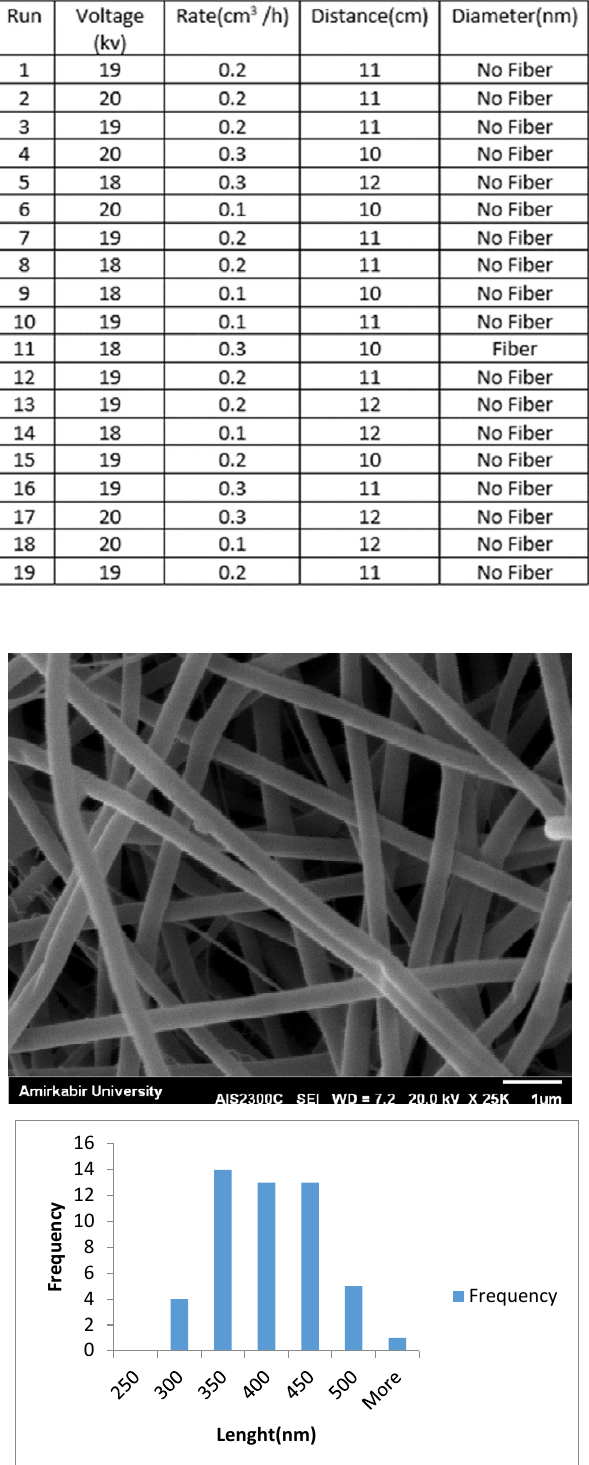
Fig. 2. SEM image of PVA/CS electrospun nanofibers before crosslinking process, average nanofibers diameter (381